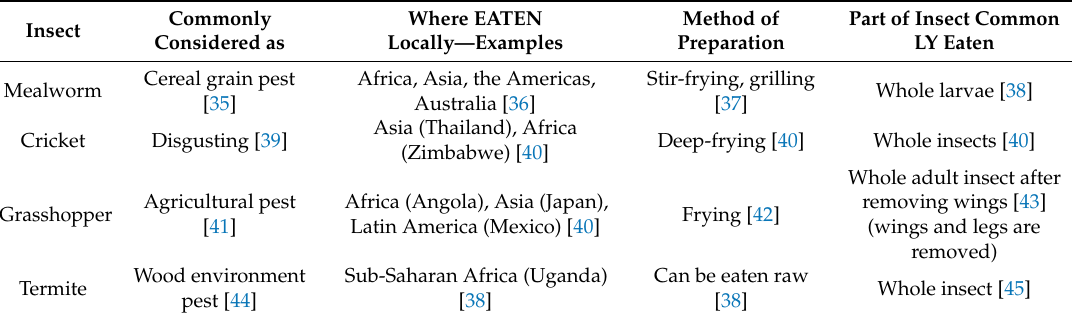
Table 1. Some edible insects and descriptions of their sensory properties.